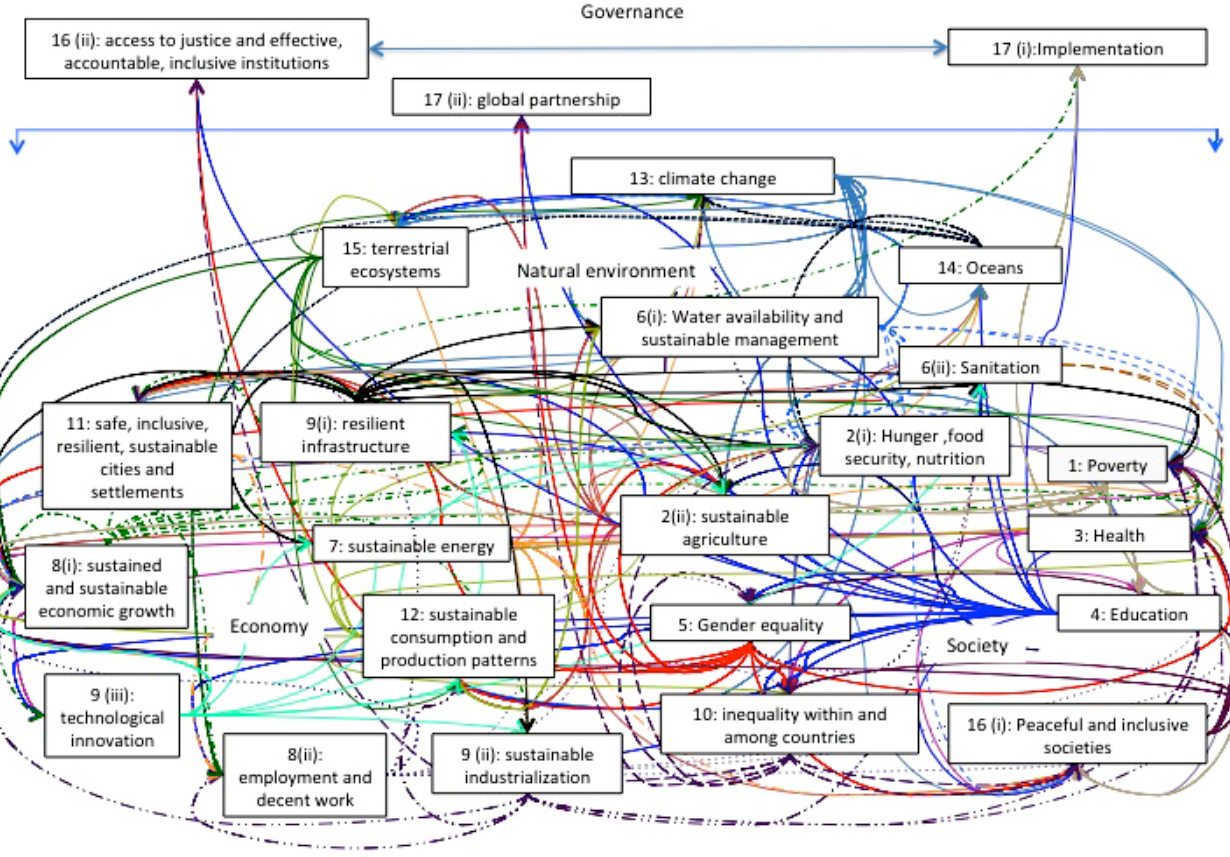
Fig. 2. Influence diagram of the SDGs: illustrating links among the SDGs. Some goals have been split into subgoals to facilitate more precise mapping. Arrows highlight where one goal is likely to have an impact on another goal. The arrowhead represents the goal that is impacted. There is no value attached to the type of impact (i.e., it could be a positive or negative impact). The arrows just illustrate that a relationship